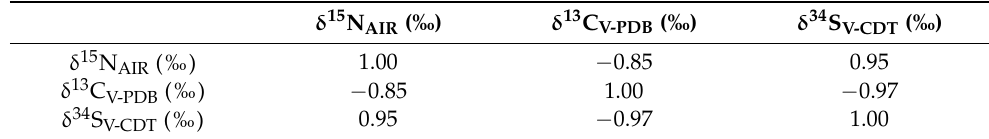
Table 3. Pearson coefficient correlation matrix of all measured bottarga